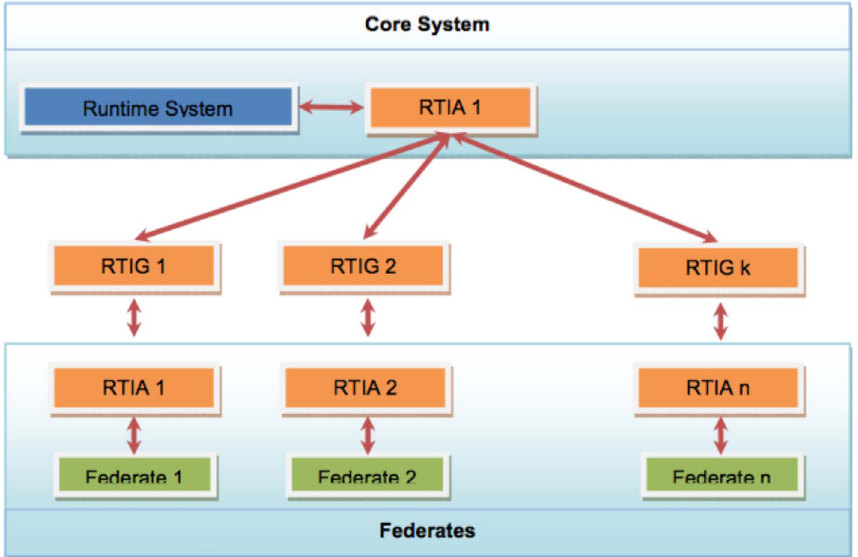
Fig. 4. RTI gateways (RTIGs) manage the simulations and transfers messages between federates. The VSWMC-P2 system supports multiple RTIGs to tackle high communication